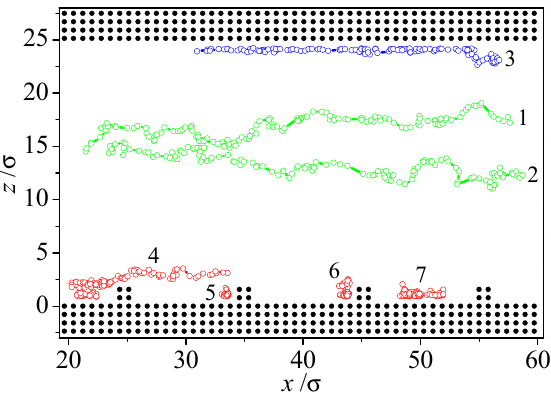
Figure 4. Typical liquid atom trajectories in a rough nanochannel ( ρ w = 2 ρ , ε wl = ε ).